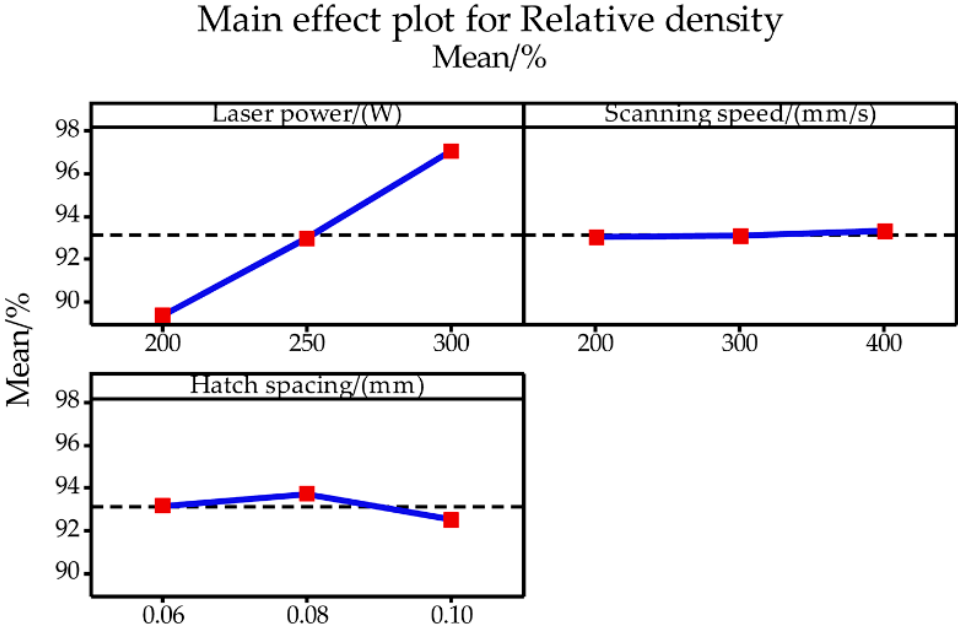
Figure 6. Main effect plots for relative density. Table 2. Results of analysis of variance for relative